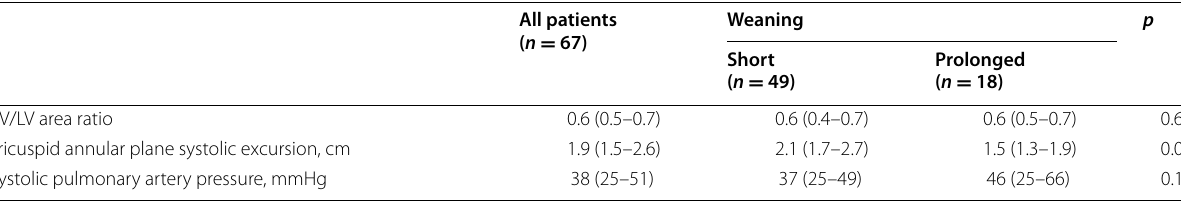
Table 2 Cardiovascular treatments and outcomes according to weaning category ( n